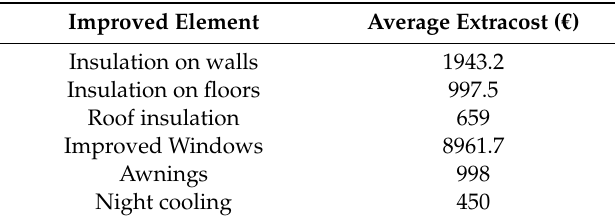
Table 8. Cost of the chosen optimal case.